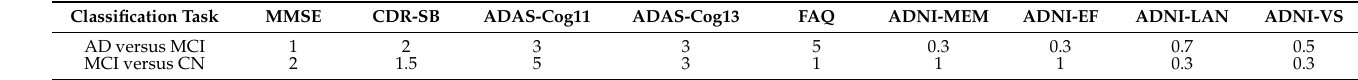
Table 3. The optimal threshold β of each neuropsychological assessment.